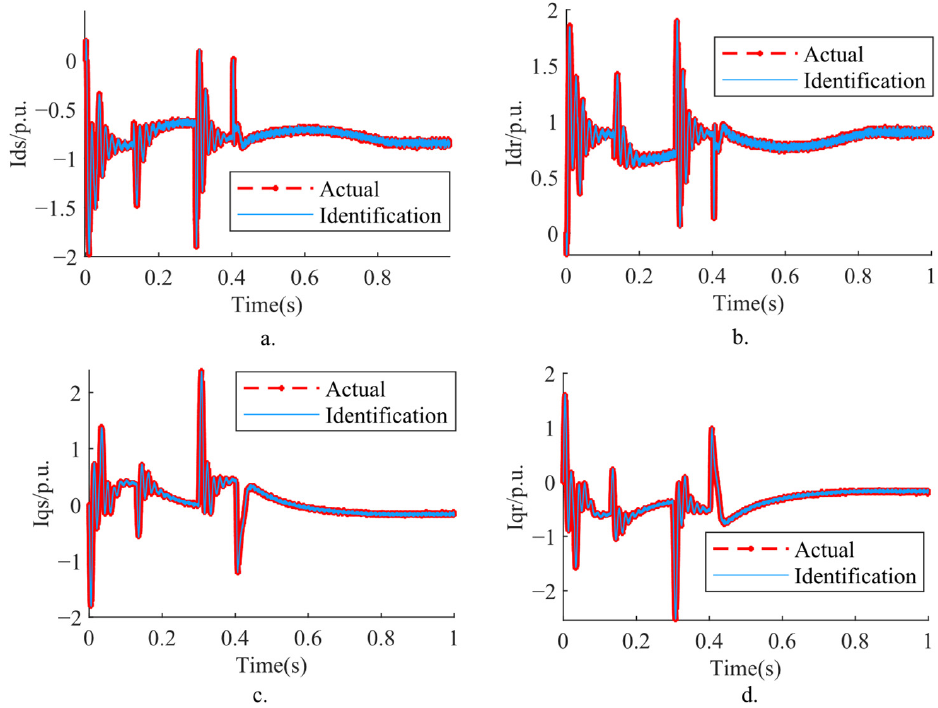
Figure 18. ( a ) Actual and identification model Ids output; ( b ) Actual and identification model Idr output; ( c ) Actual and identification model Iqs output; ( d ) Actual and identification model Iqr output.